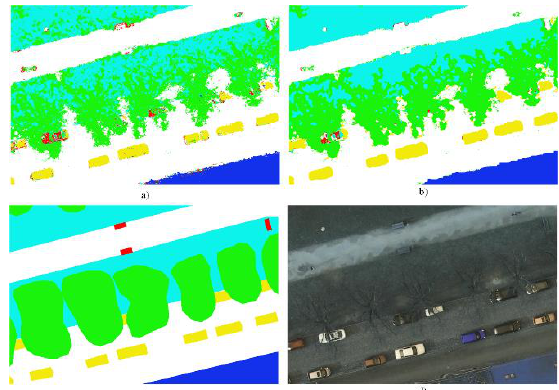
Figure. 13. Ground truth overestimation a) Result of classification b) Result of spatial refinement c) Ground truth d) Original RGB image.